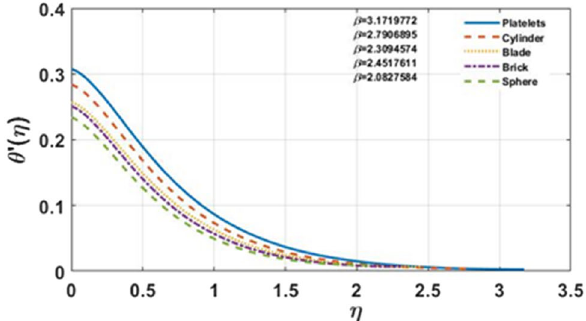
0.5 , S 0.4 , Ec 0.1 , K = = =